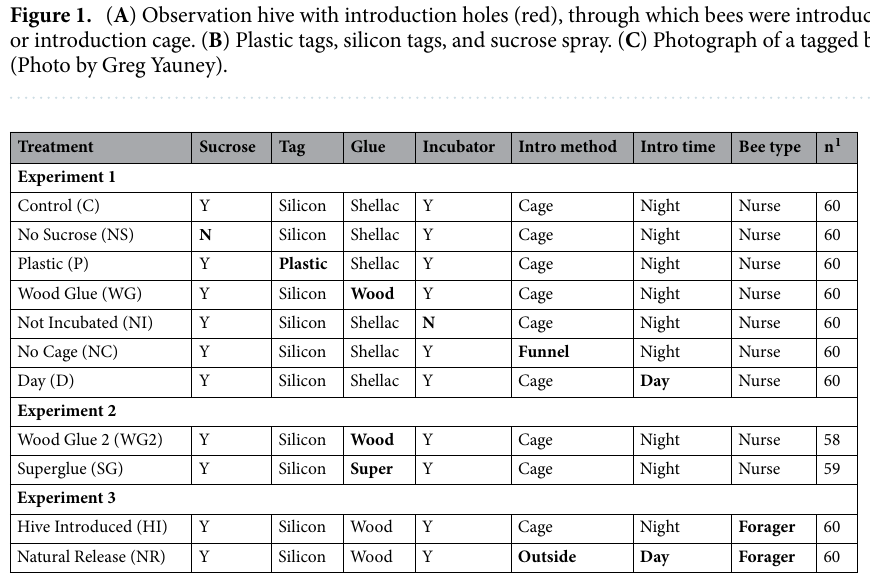
1 n denotes number